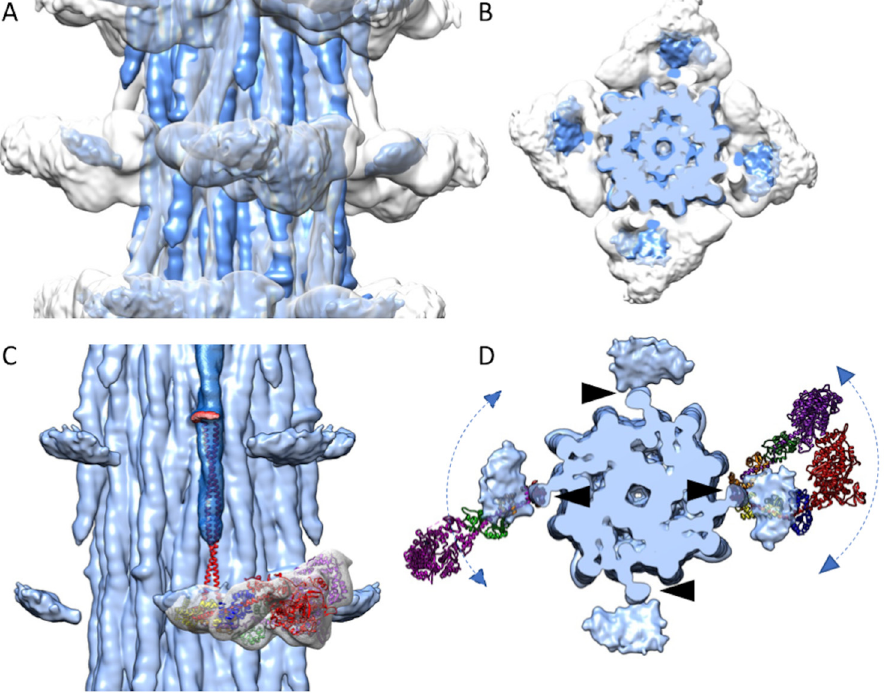
Figure 3. Disordered myosin heads of Bombus compared with those of Lethocerus . The Bombus density map (blue) is superimposed on the Lethocerus density map (grey) in both side view ( A ) and top view ( B ). ( C ) An atomic model of the IHM (Blocked Head heavy chain, red; Essential Lght Chain (ELC), blue; Regulatory Light Chain (RLC), yellow; Free Head heavy chain, purple; ELC, green; RLC, orange) along with the myosin head density of the Lethocerus reconstruction is shown. The floating densities from Bombus (blue) represent the average position of otherwise highly disordered myosin heads. The crystal structure of cardiac S2 (red) is aligned to the Bombus S2 density. The S2 atomic model points directly at the floating myosin head density. Note that the Lethocerus features (map and atomic model) are aligned to the cardiac S2 atomic model and not to their position in the relaxed Lethocerus thick filaments. ( D ) Axial view with atomic models of the Free Head (left) and IHM (right) from relaxed Lethocerus thick filament superimposed on the Bombus density map with the N-terminal domain of the RLC under the proximal S2. The position of the proximal S2 (black arrowheads) is juxtaposed with the inner edge of the floating density. The atomic models serve to illustrate how a floating density might be explained by mostly azimuthal movements of either individual myosin heads or interacting heads motifs. The floating density in Bombus would appear to mostly represent the average position of the disordered RLC.